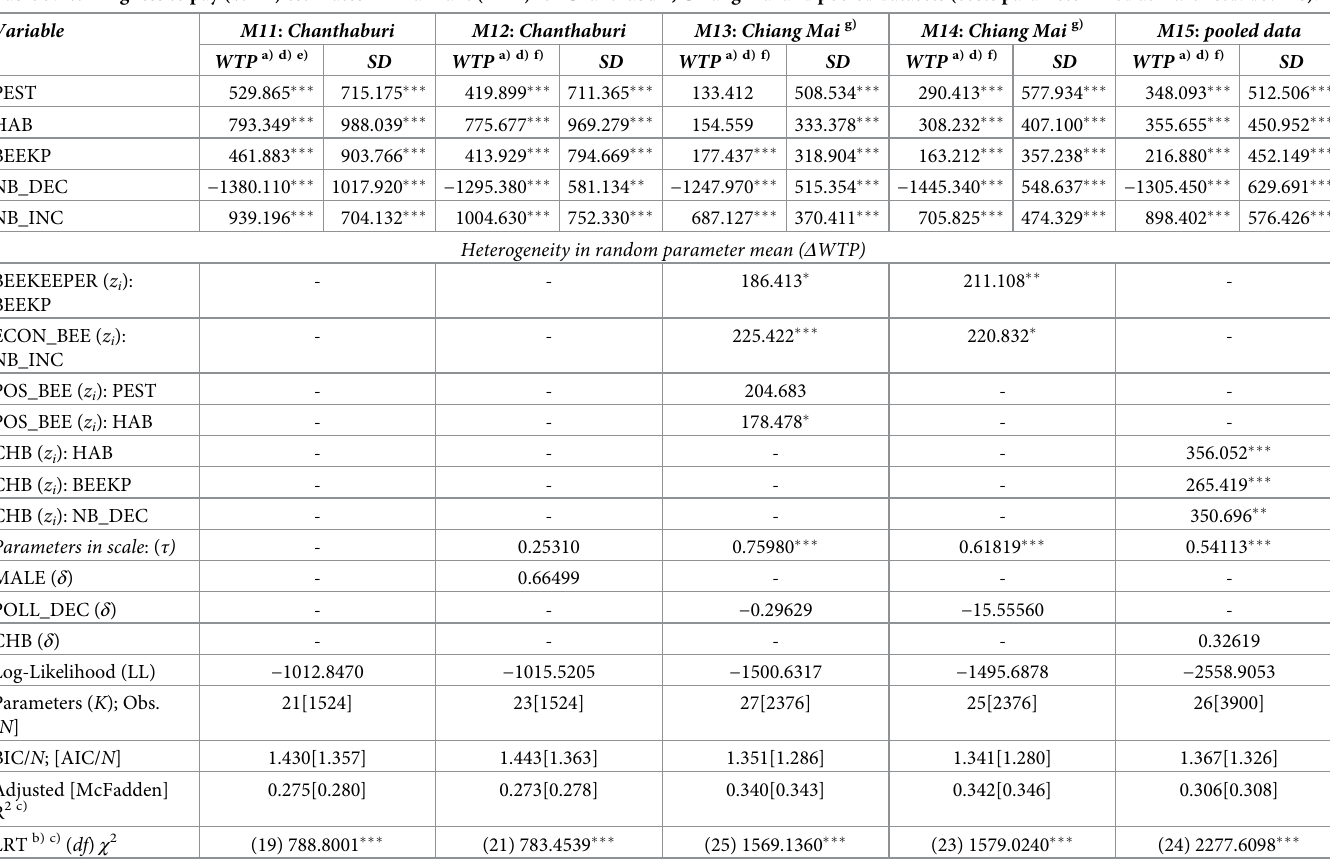
Table 5. Willingness to pay (WTP) estimates in Thai Baht (THB) for Chanthaburi, Chiang Mai and pooled datasets (costs parameter fixed at 1 with std. dev = 0).